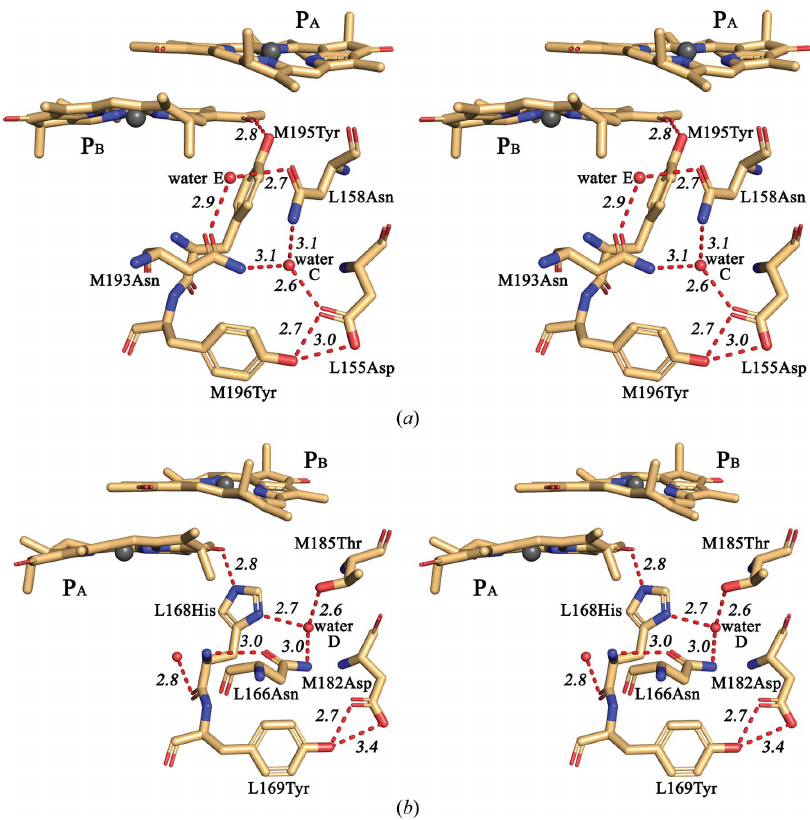
Figure 7 Stereoviews of the hydrogen-bonding networks near Tyr M195 ( a ) and His L168 ( b ) in B. viridis RC. All distances are shown in A˚